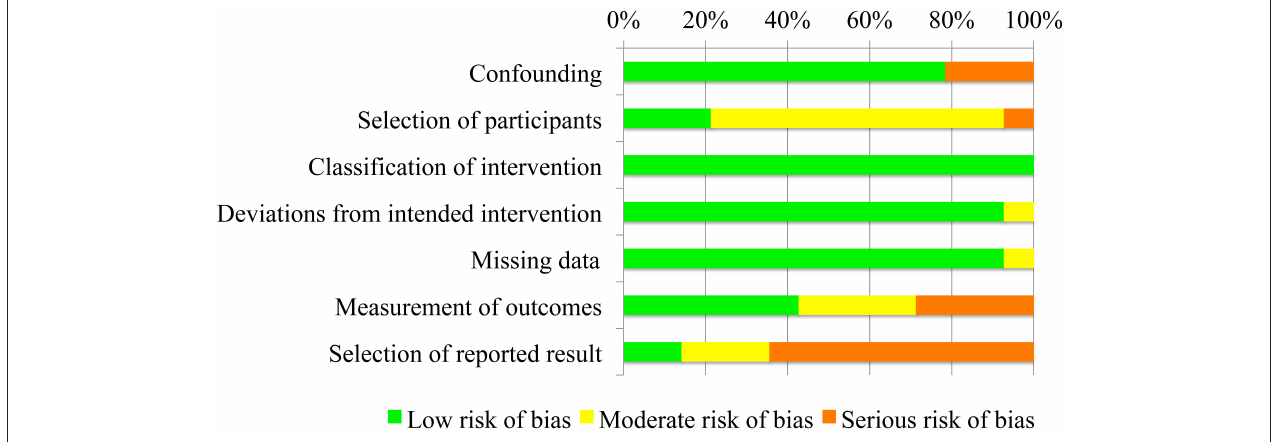
FIGURE 2 | Risk of bias of the fourteen included studies presented as percentages across all included